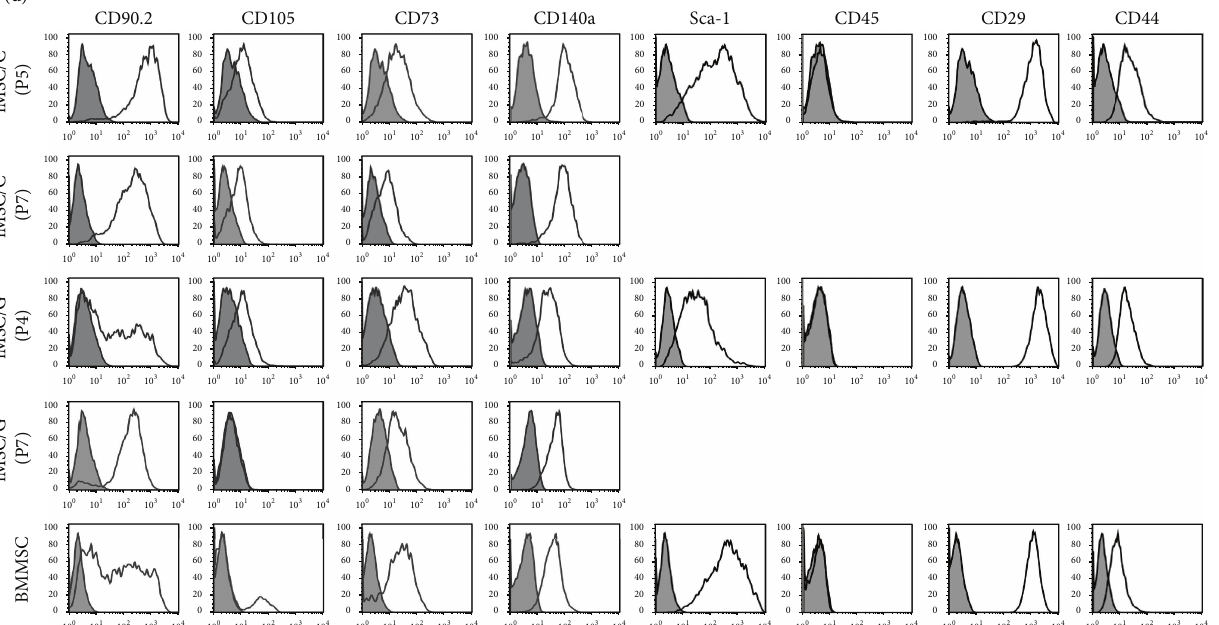
Figure 1: Derivation of mouse iPSC-derived mesenchymal stem cells (iMSC). (a) Protocol for derivation of iMSCs. iPSCs were maintained on mouse embryonic fibroblast (MEF) in iPS medium with leukemia inhibitory factor (LIF) and harvested and dissociated into single cells that were seeded into gelatin A - or collagen B -coated plates. After 1 day, the iPS medium was supplemented with an equal volume of the derivation medium with dexamethasone and ascorbic acid, and after 2 days, the medium was replaced with derivation medium. After 8 days, cells (passage zero; P0) were harvested and replaced in new gelatin- or collagen-coated plates in expansion medium. (b) Adherent spindle- shaped fibroblast-like cells at P0 appeared on 8-derivation day. (c) Homogenous fibroblast-like cells at P3. (d) Characterization of iMSCs on gelatin (iMSCs/G) and on collagen (iMSCs/C) at P4 to P7. Bone marrow (BM) MSC at P5 was provided by cell sorting from mouse bone marrow. The gray histogram represents the negative control staining with fluorescence-conjugated isotype IgG and white overlay represents antigen at CD90.2, CD105, CD73, CD29, CD44, CD45, Sca-1, and CD140 𝛼